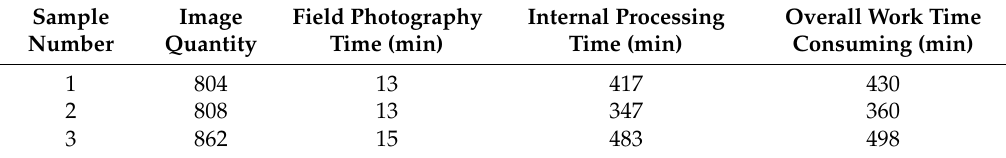
Table 5. Comparison of the efficiency of constructing 3D point clouds based on